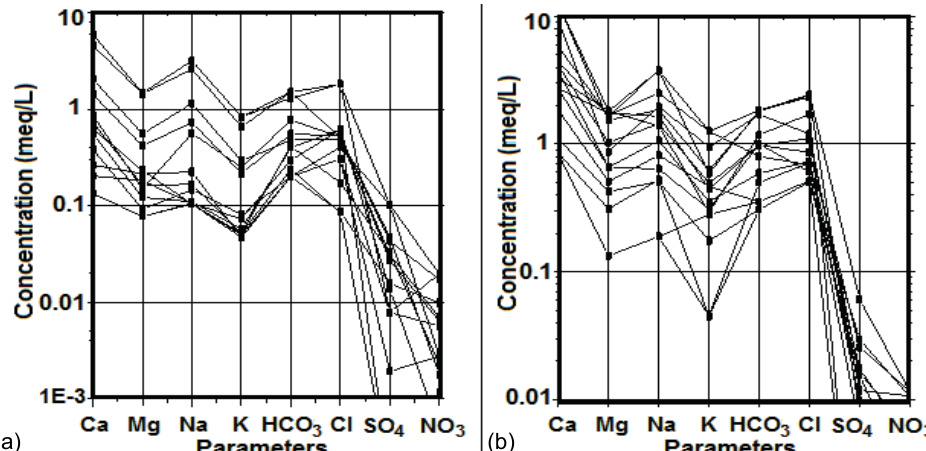
Fig. 4 Schoeller diagram for samples from urban (a) and peri-urban areas